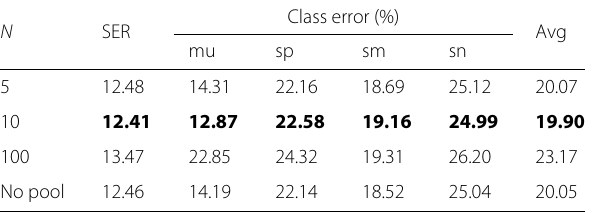
Table 7 SER, error per class and average class error for the resegmentation on the test partition for different